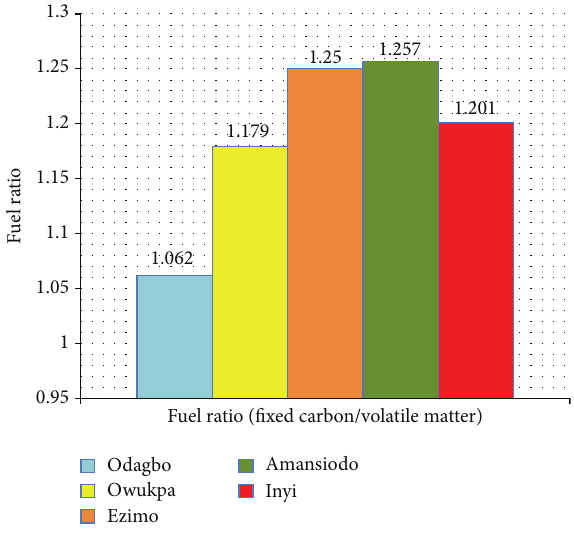
Figure 1: Fuel ratio of the five coal samples.